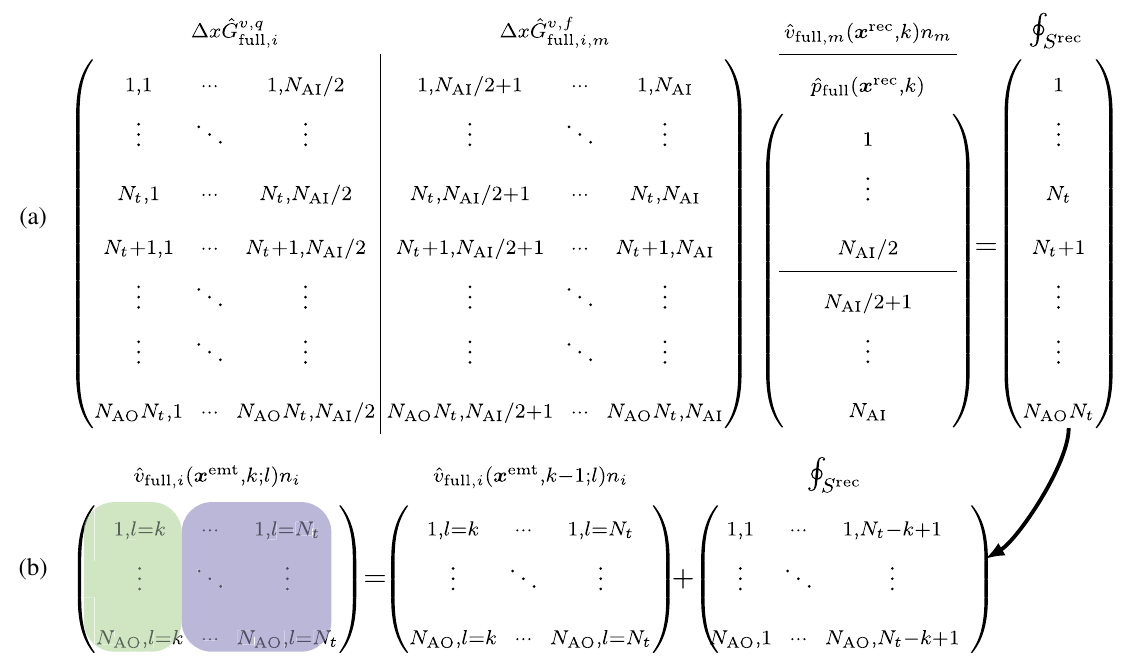
FIG. 2. Schematic of the numerical implementation of Eq. (4). (a) The surface integral is replaced by a matrix-vector multiplication of the extrapolation Green ’ s functions with the normal particle velocity and pressure recorded at S rec . Quantities N t , N , and N AI AO correspond to the number of time steps and the numbers of input and output channels (or sensors and sources), respectively. Note that the extrapolation Green ’ s functions are scaled by the separation distance of the sources Δ x to account for the integration step size. (b) The N 1 is reshaped to a matrix with dimensions N resulting column vector with dimensions N × N t (black arrow), which is used in t × AO AO the recursive evaluation of the time-convolution integral to yield the normal particle velocity at S emt . At each time step k , the leftmost column of the resulting matrix (green box) is applied as the boundary conditions on S emt . The values for l > k (purple box) are stored for later use.